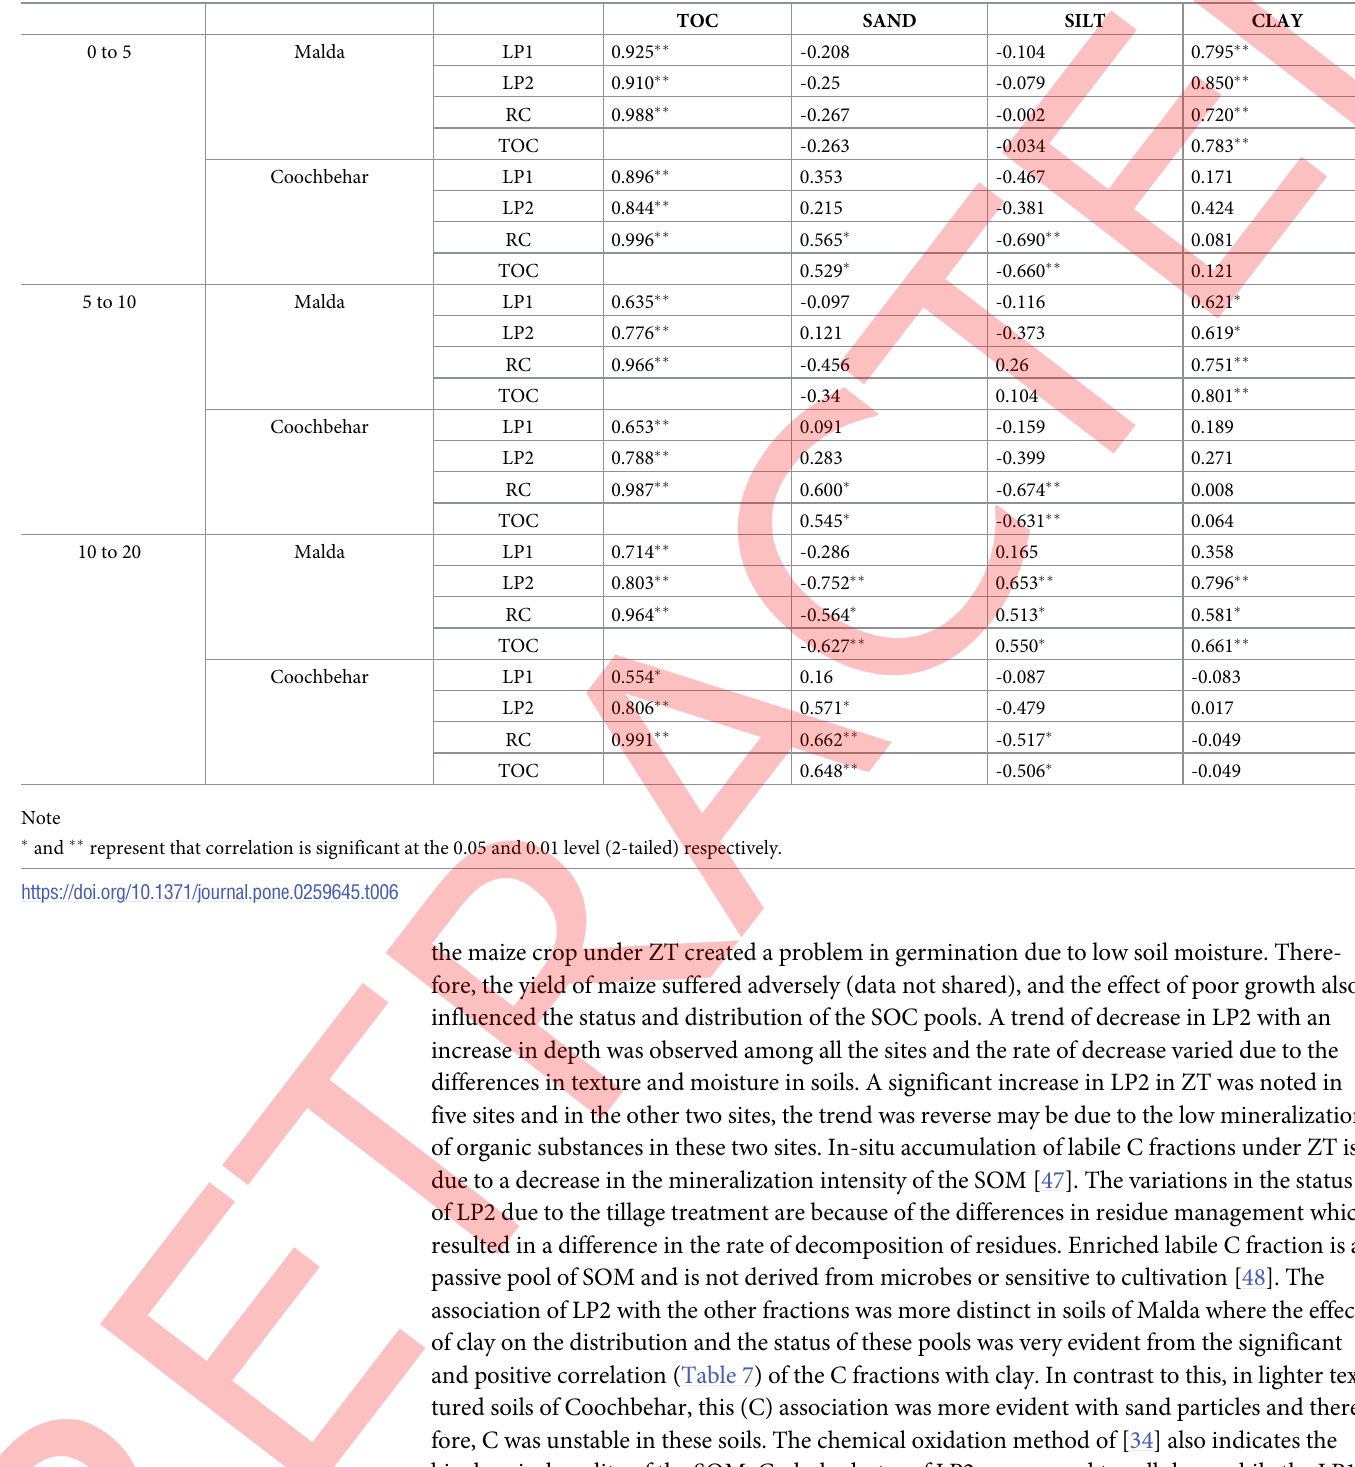
Table 6. Relationship of LP1, LP2, and RC with TOC and soil textural